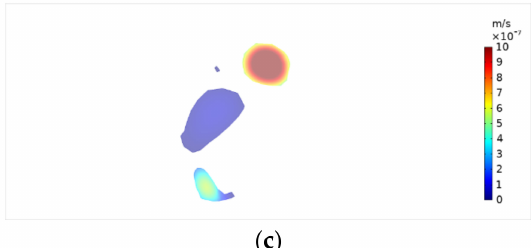
Figure 14. Distributions of pressure field and velocity field with pressure difference of 9 Pa. ( a ) distribution of pressure field; ( b ) distribution of velocity field; ( c ) velocity profile in the mid- dle part of model.